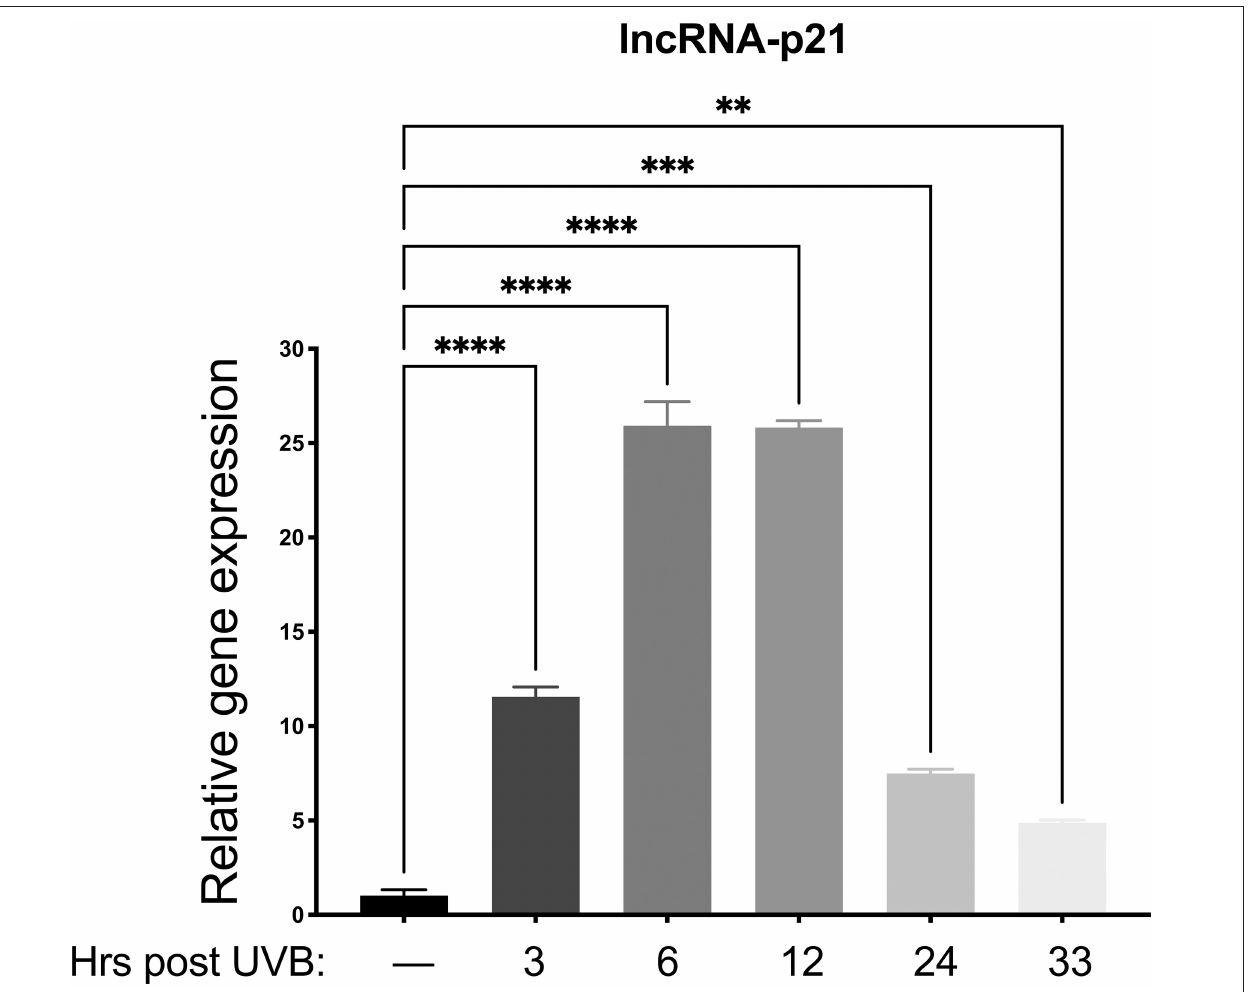
FIGURE 2 | Upregulation of long non-coding (lnc.) RNA-p21 in canine keratinocytes in response to exposure to ultraviolet B (UVB) light. Normal canine keratinocytes were exposed to UVB (10 mJ/cm 2 ) and cell lysates collected at different times points post-irradiation for RNA isolation. Real time PCR was performed to determine expression of lncRNA-p21. Resulting Cq values were normalized to the Cq value of the reference gene and calibrated to transcript levels in non-UVB exposed keratinocytes. Experiments were performed in duplicate and repeated in three independent experiments. Results of one representative experiment is shown and expressed as mean ± SD. ** p < 0.01; *** p < 0.001; **** p <